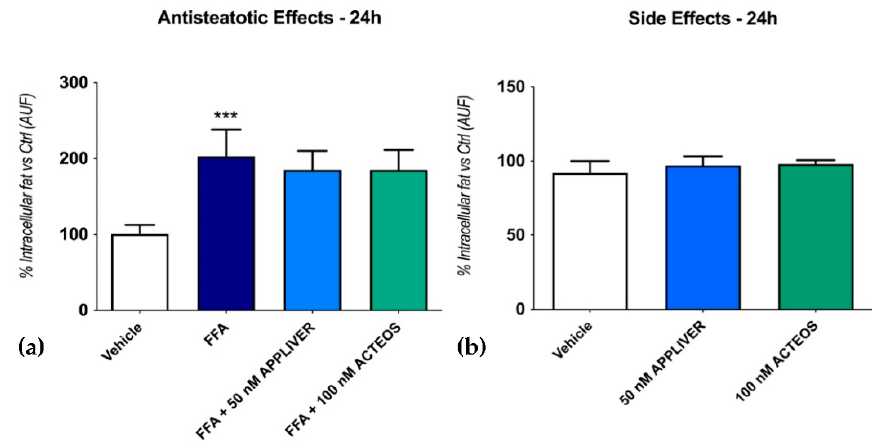
Figure 1. Assessment of the effect of APPLIVER and ACTEOS as antisteatotic ( a ) and its side effects ( b ) after 24 h on hepatocytes. Values presented are the mean ± SD of three independent experiments. *** p < 0.001 vs. vehicle. Abbreviations: AUF, arbitrary unit of fluorescence; FFA, free fatty acids.